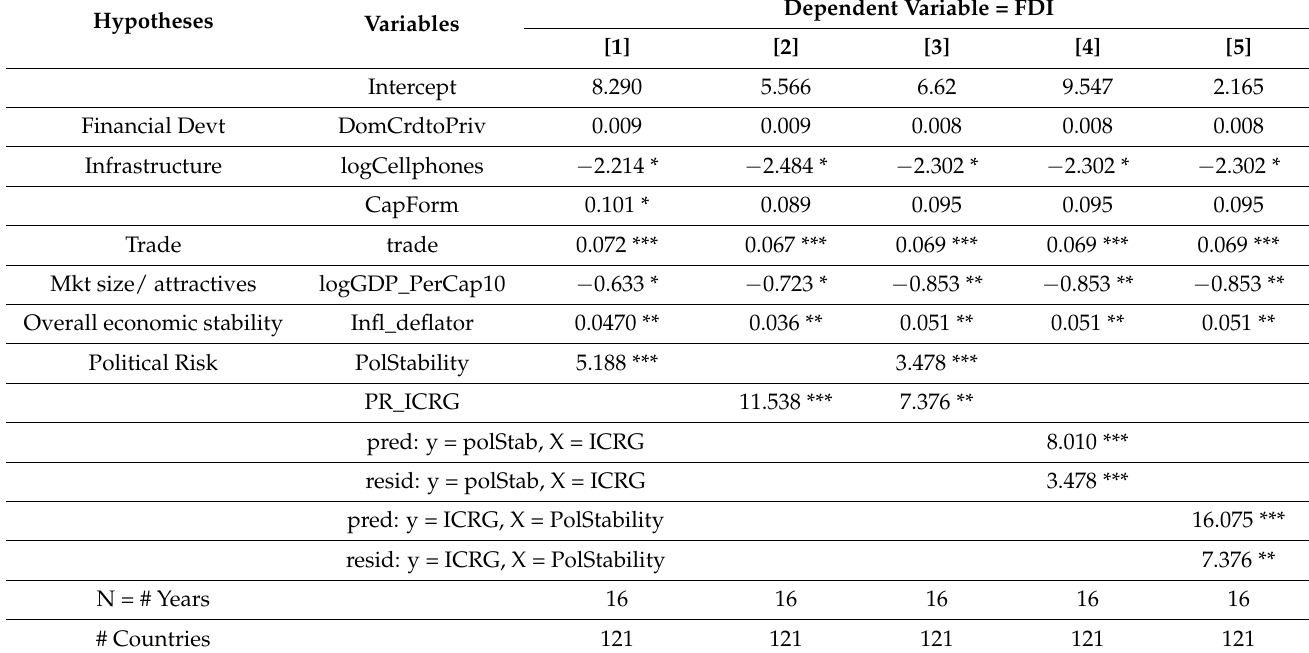
Table 7. Information Content of the Political Stability vis- à -vis ICRG’s Political Risk